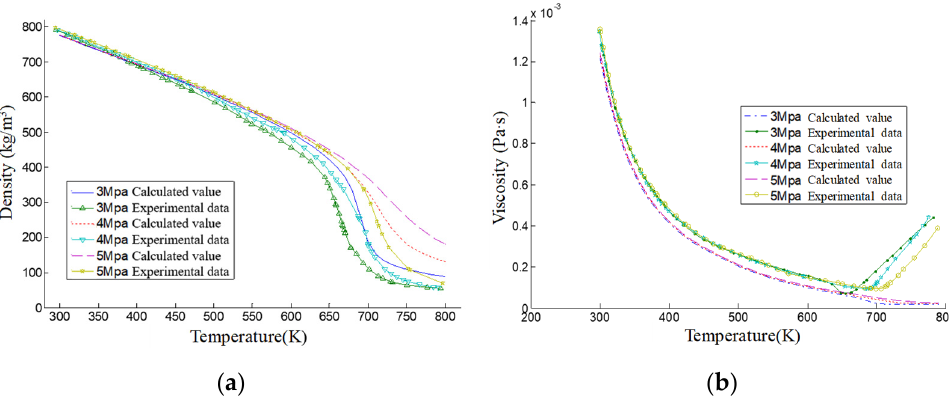
Figure 3. Comparisons of calculated values and experimental data ( a ) density under different pressure conditions ( b ) viscosity under different pressure conditions, with different temperatures of kerosene.